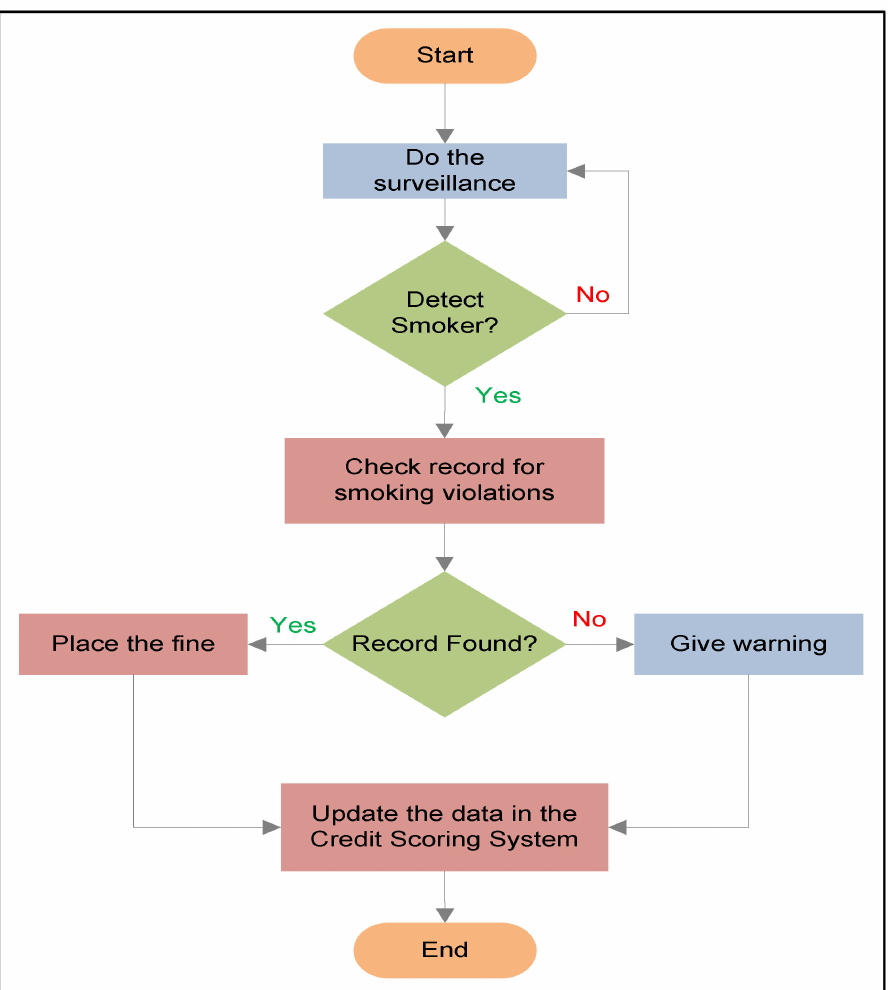
Figure 2. Flow diagram of working